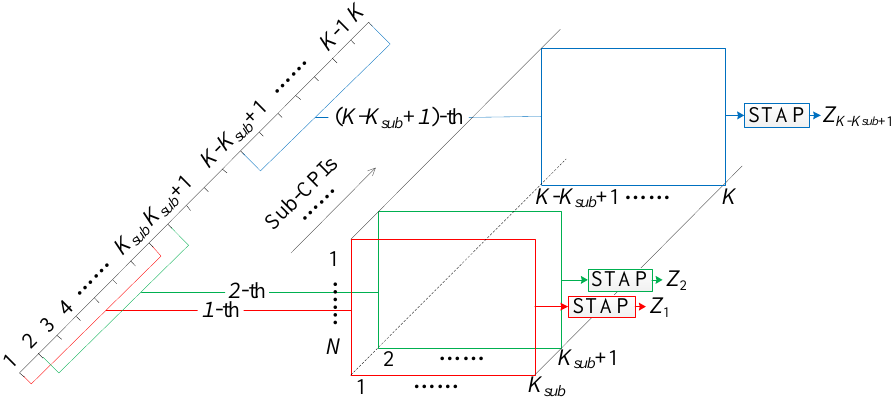
sub-CPI is modeled by extracting corresponding rows of x ( τ , 0, B ) , according to the rules of the sliding window processing, which is denoted by x j ( τ , 0, B ) in the j -th sub-CPI. For the further long-CPI coherent accumulation, it is important to constrain the target Doppler history of clutter-suppressed STAP outputs among sub-CPIs, including the aspects of linear phase response constrained STAP filters design and the mitigation of dynamic TG-induced target attenuation, which are summarized as follows.